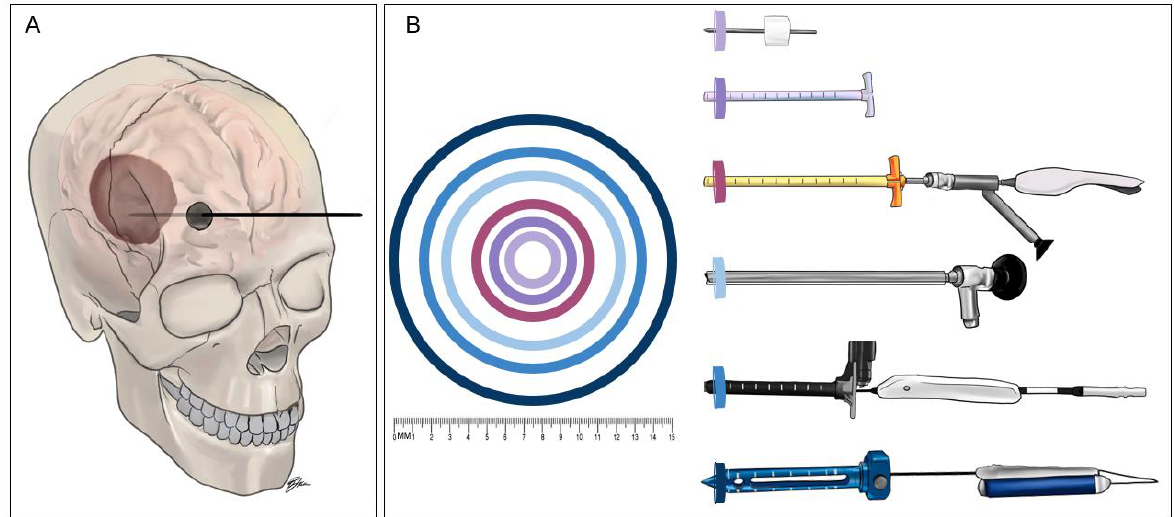
Figure 2. The relative sizes of the instruments of minimally invasive surgery for intracerebral hemorrhage (ICH) evacuation. ( A ) Generic sketch of the minimally invasive approach to intracerebral hemorrhage evacuation. A small craniotomy is made and the chosen device is inserted through the cranial opening and into brain parenchyma until reaching the hematoma. ( B ) Sketches of the ICH evacuation devices with concentric rings demonstrating the widest diameter of the instrument inserted through brain parenchyma for each technique. The color of each concentric ring corresponds to the color at the tip of the device in the illustrations. The devices, from top to bottom, are the craniopuncture YL-1 needle (outer diameter: 3.0 mm), the 14F vascular sheath used in the Minimally Invasive Surgery Plus Rt-PA for ICH Evacuation (MISTIE) procedure (4.8 mm), the Artemis device inserted through a 19F vascular sheath and a 3-port Endoscope such as the Storz Lotta (6.3 mm), the clear sheath used during endoscope-assist procedures (10.0 mm), the Aurora Surgiscope (11.5 mm), and the BrainPath endoport (15.8 mm).